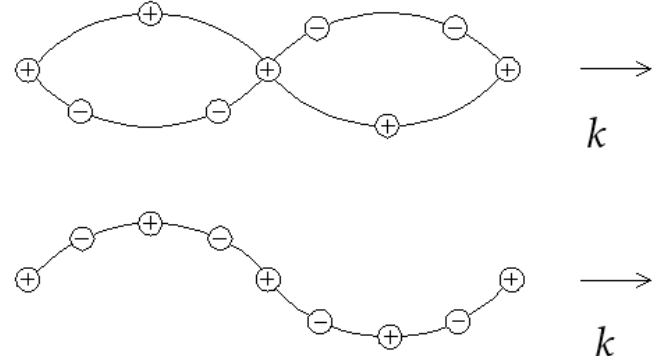
Figure 3. TO (upper) and TA (lower) phonons in a linear diatomic lattice.